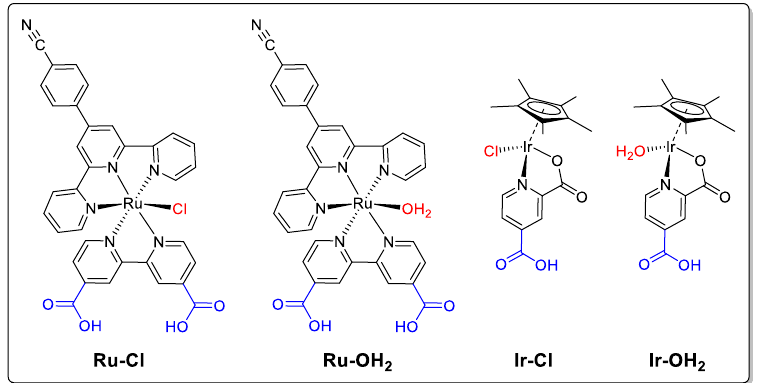
Figure 1. Molecular water oxidation (pre-)catalysts used in this work. The anchoring groups are shown in blue, the active site ligand (OH 2 ) or protecting group ligand (Cl) are shown in red.